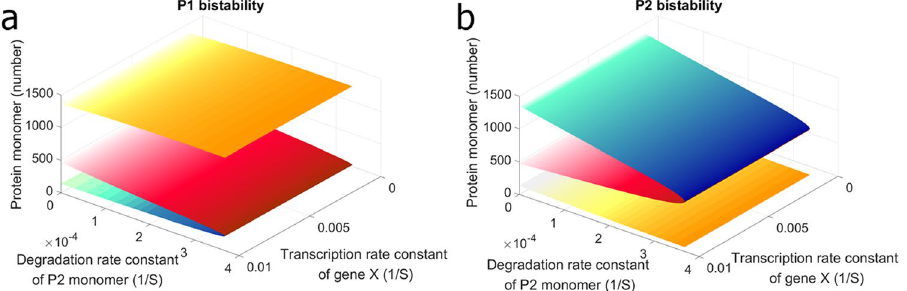
Figure 3. The bistable behaviors with the assumption that the only consumption of complexes X and Y comes from dissociation. The axis of the transcription rate indicates the expression level of gene X. Note that the shift along this axis caused no difference from the aspect of deterministic steady state analysis. The axis of the degradation rate represents the consumption rate of protein P2 monomer by degeneration. The movement along this axis altered the deterministic bistable behaviors.